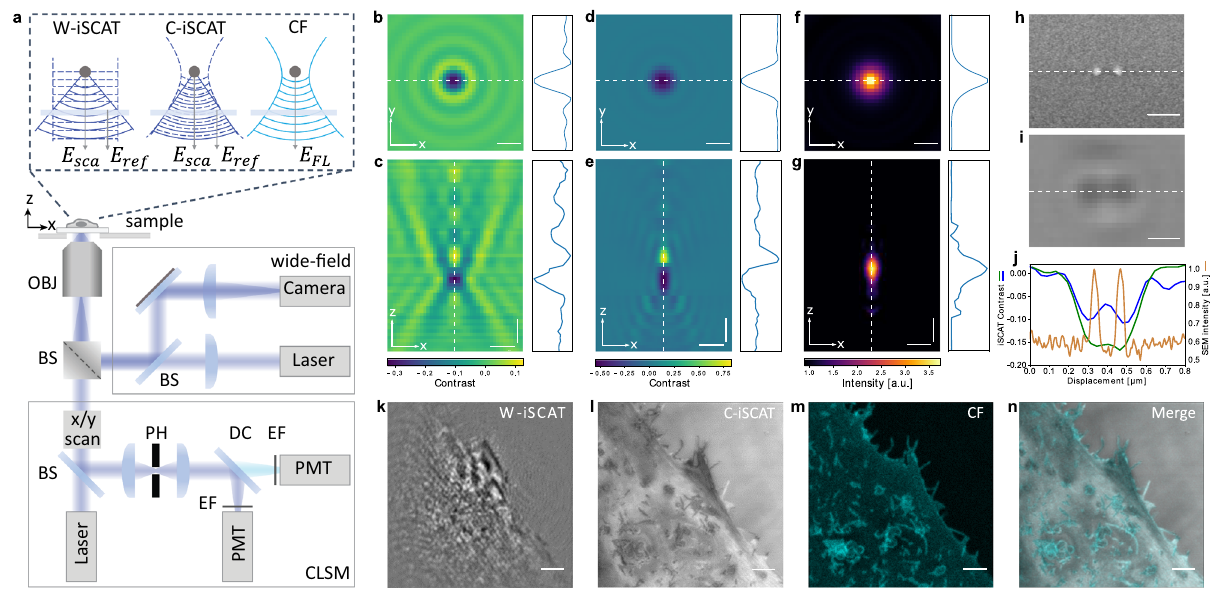
Fig. 1 | Schematics and characterization of the optical setup. a The main com- ponents of a confocal laser scanning microscope (CLSM), which is extended to perform iSCAT microscopy in both wide- fi eld and confocal modes. OBJ objective, BS beam splitter, PH pinhole, DC dichroic mirror, EF emission fi lter, PMT photo- multiplier tube. Inset: Wavefronts of laser illumination (dashed lines) and sample radiation (solid lines) for the three modalities. Lateral and axial point spread functions (PSF) of a 100nm fl uorescence-labeled polystyrene bead for wide- fi eld iSCAT( b , c ),confocaliSCAT( d , e ),andconfocal fl uorescence( f , g )modalities.The focus wasscanned over 4 μ m in stepsof 30nm in c , e , and g . The background was accounted for in each z plane. Curves on the right-hand side depict the intensity pro fi lesalongthecrosssectionsshownineach fi gure.Horizontalandverticalscale bars are 200nm and 500nm, respectively. h Scanning electron micrograph of a